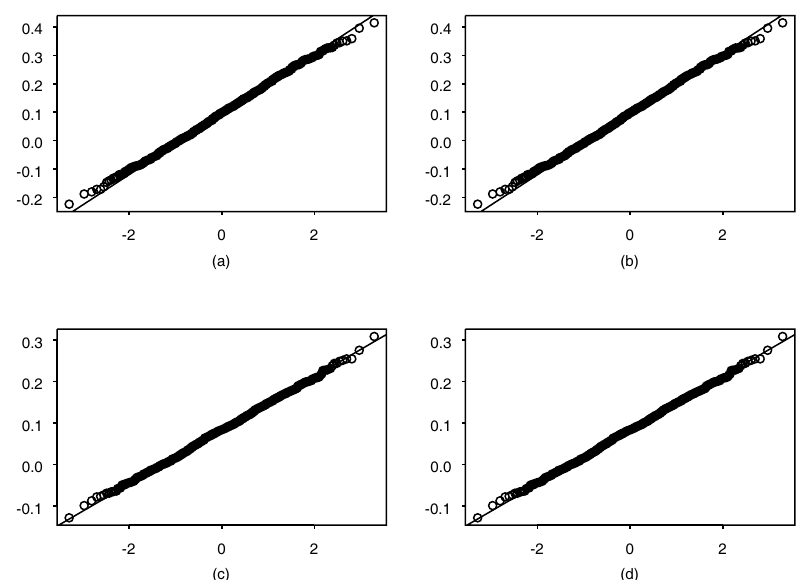
Figure 3 – Plot ( , ) x y of the quantiles of the standard normal distribution ( x -axis) and the corre- sponding sample values of the linear approximation (4) ( y -axis), sample size 4 n (cid:32) (panel (a)) and 7 n (cid:32) (panel (c)). Plot ( , ) x y of the quantiles of the standard normal distribution ( x -axis) and the sample values of the higher-order linear approximation (5) ( y -axis), sample size 4 n (cid:32) (panel (b)) and 7 n (cid:32) (panel (d)). The ratio of means example, with bivariate folded-normal observations from correlated ( 0.5 (cid:85) (cid:32) ) marginals.